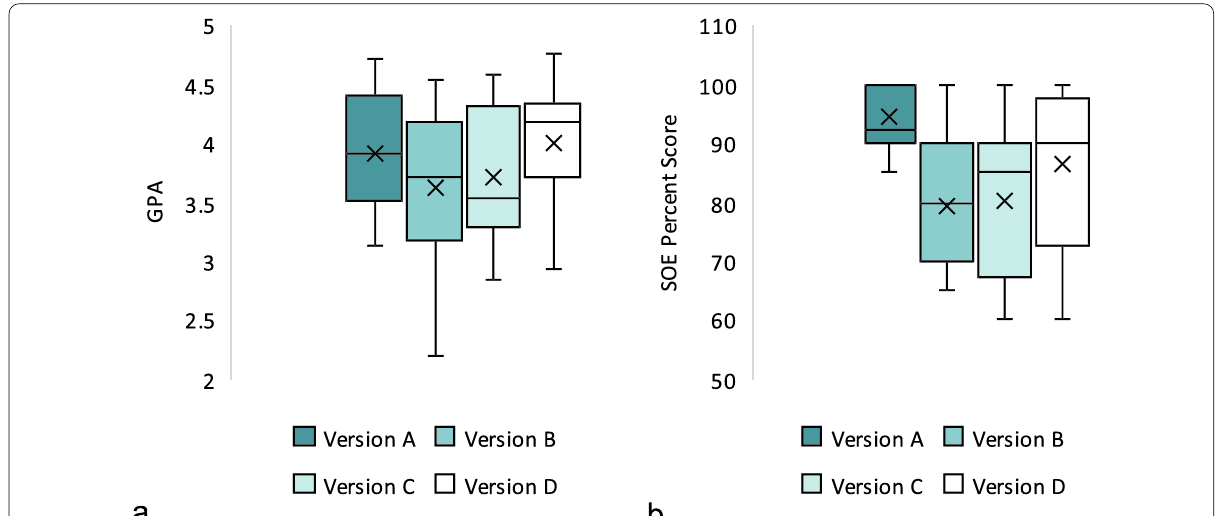
Fig. 8 Comparison of boxplots of GPAs ( a ) and SOE percent scores ( b ) between four SOE versions. The GPA means were not significantly different between the four groups. Only SOE percent scores mean for version A was significantly higher than the other versions ( p